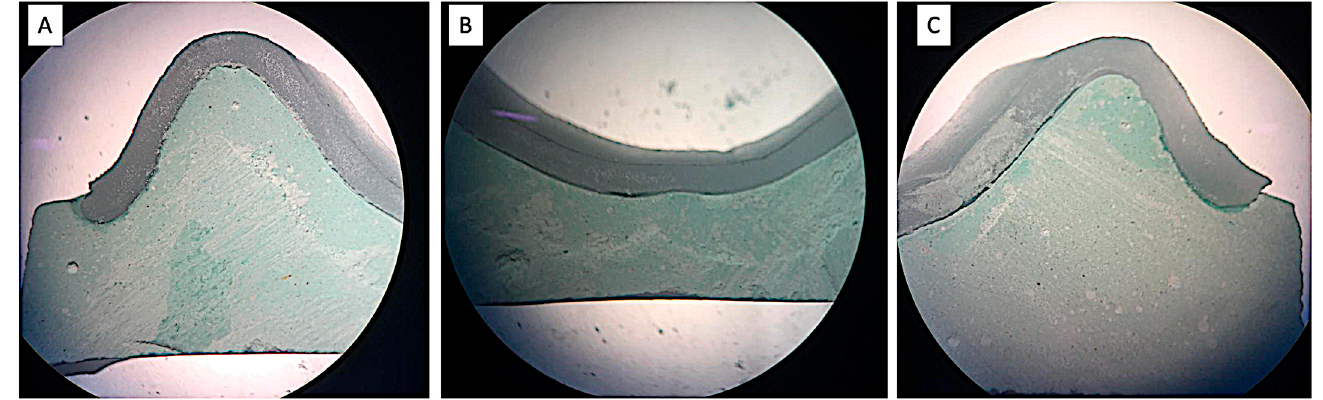
Figure 6. Discrepancy Seen Under the Stereomicroscope at ( A ) Right Ridge Crest; ( B ) Mid-Palate Region; ( C ) Left Ridge Crest. Region; ( C ) Left Ridge